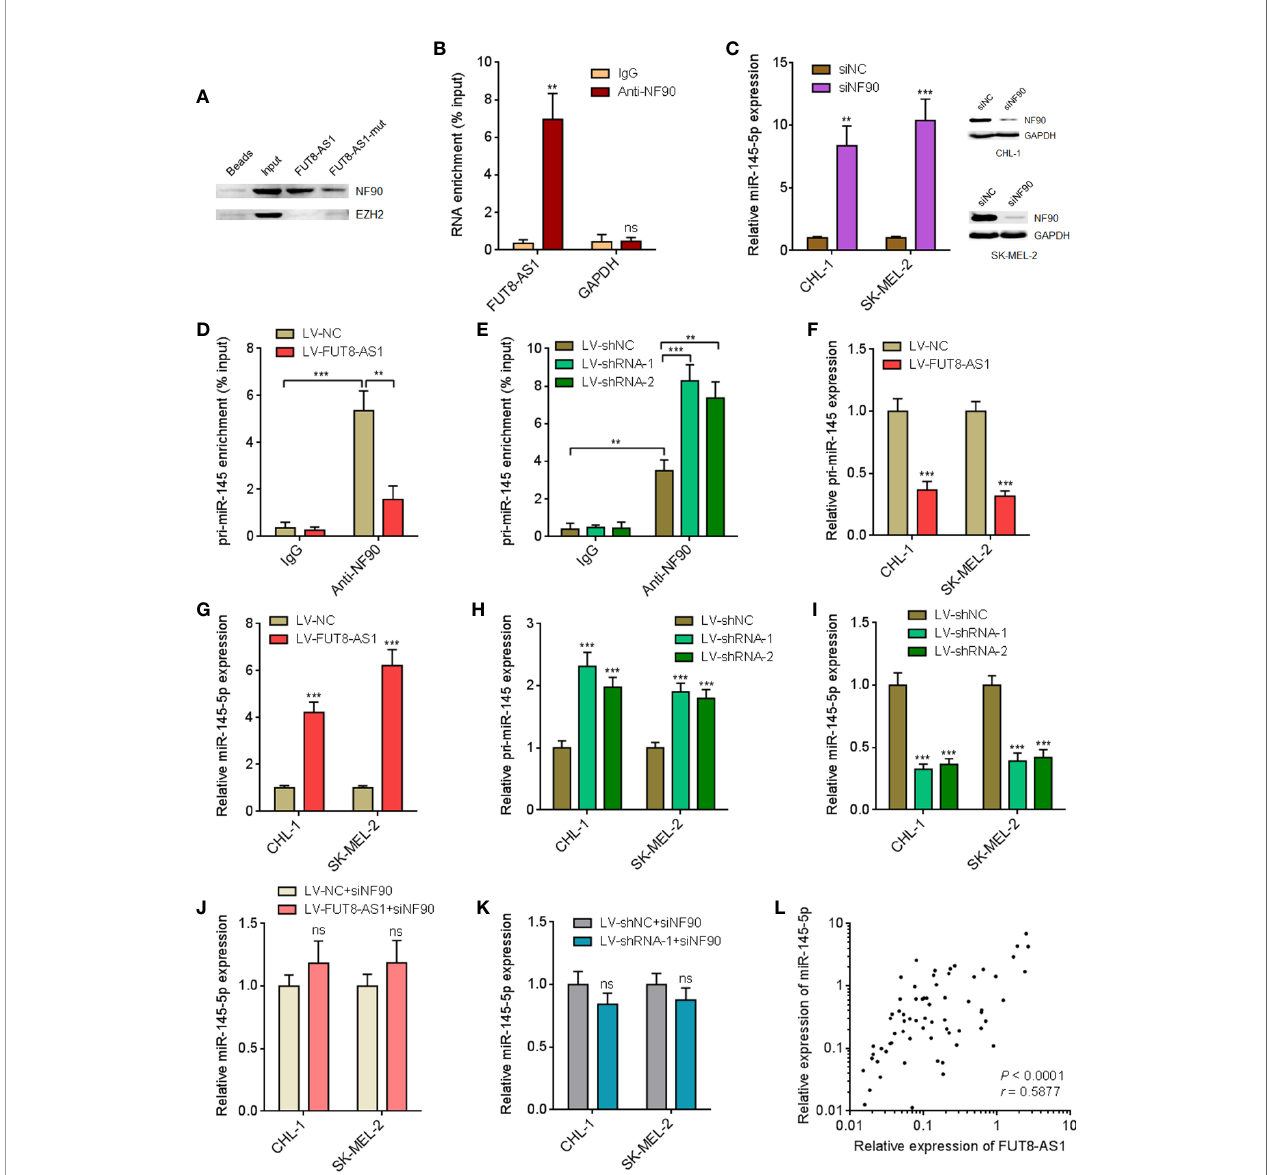
FIGURE 5 | FUT8-AS1 upregulates miR-145-5p via binding NF90. (A) RNA pull-down assays using in vitro transcribed wild-type or NF90 binding site mutant FUT8- AS1. The enriched proteins were measured by western blot. (B) RIP assays were performed in CHL-1 cells using NF90 speci fi c antibody or non-speci fi c IgG. The enriched RNA was detected by real-time PCR. (C) After transfection of NF90 speci fi c siRNAs pool or non-targeting negative control (NC) siRNAs into CHL-1 and SK- MEL-2 cells, miR-145-5p expression levels and NF90 protein expression levels were measured by real-time PCR and western blot, respectively. (D) RIP assays were performed in SK-MEL-2 cells overexpressing FUT8-AS1 or control using NF90 speci fi c antibody or non-speci fi c IgG. The enriched RNA was detected by real-time PCR. (E) RIP assays were performed in CHL-1 cells silencing FUT8-AS1 or control using NF90 speci fi c antibody or non-speci fi c IgG. The enriched RNA was detected by real-time PCR. (F) pri-miR-145 expression levels in CHL-1 and SK-MEL-2 cells overexpressing FUT8-AS1 or control were measured by real-time PCR. (G) Mature miR-145-5p expression levels in CHL-1 and SK-MEL-2 cells overexpressing FUT8-AS1 or control were measured by real-time PCR. (H) pri-miR-145 expression levels in CHL-1 and SK-MEL-2 cells silencing FUT8-AS1 or control were measured by real-time PCR. (I) Mature miR-145-5p expression levels in CHL-1 and SK-MEL-2 cells silencing FUT8-AS1 or control were measured by real-time PCR. (J) After transfection of NF90 speci fi c siRNAs pool into CHL-1 and SK-MEL-2 cells overexpressing FUT8-AS1 or control, mature miR-145-5p expression levels were measured by real-time PCR. (K) After transfection of NF90 speci fi c siRNAs pool into CHL-1 and SK-MEL-2 cells silencing FUT8-AS1 or control, mature miR-145-5p expression levels were measured by real-time PCR. (L) miR-145-5p expression levels in the same 68 melanoma tissues used in Figure 1 were measured by real-time PCR. The correlation between miR-145-5p and FUT8-AS1 expression levels in these 68 melanoma tissues was calculated by Spearman correlation analysis. r = 0.5877, P < 0.0001. For (B – K) , data are presented as mean ± SD. ** P < 0.01, *** P < 0.001, ns, not signi fi cant, by two-tailed unpaired t test [ B , C , D , E (the comparison between IgG and Anti-NF90 for LV-shNC), F , G , J , K ] or one-way ANOVA followed by Dunnett ’ s multiple comparisons test [ E (the comparison between LV-shRNA-1, LV-shRNA-2, and LV-shNC for Anti-NF90), H , I